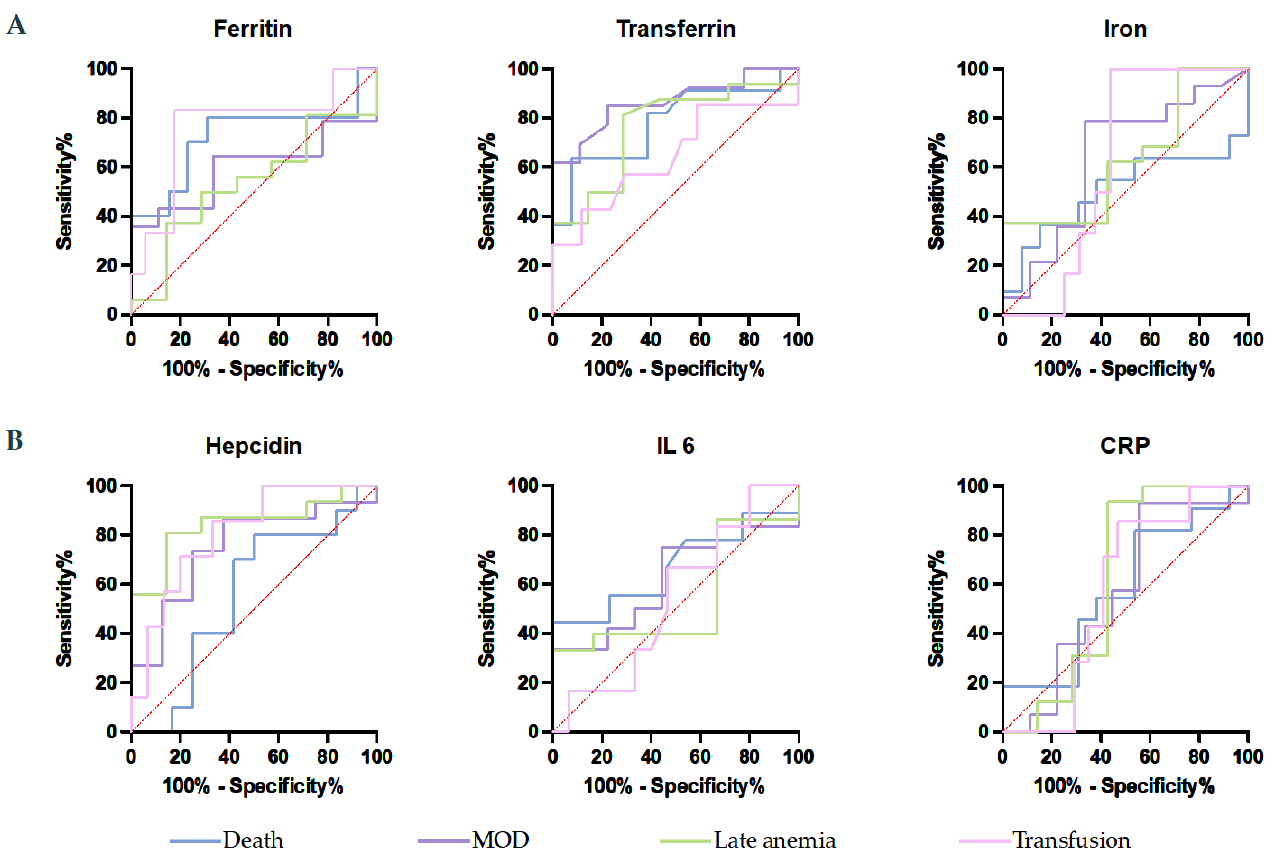
Figure 2. Predictive value of serologic iron ( A ) and inflammatory ( B ) parameters to identify non survivors, patients who developed MOD and LA. IL 6 = interleukin 6; CRP = C reactive protein; MOD = multiple organ dysfunction.